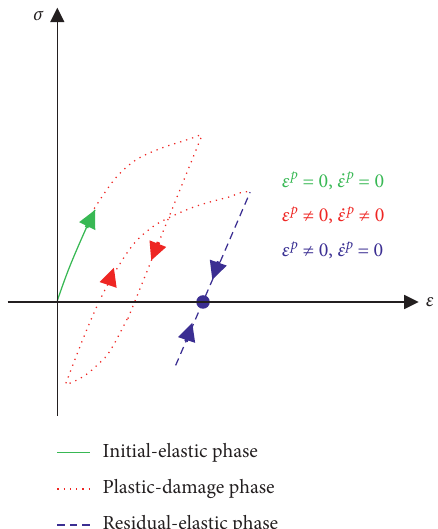
Figure 1: Schematic diagram of the residual-elastic